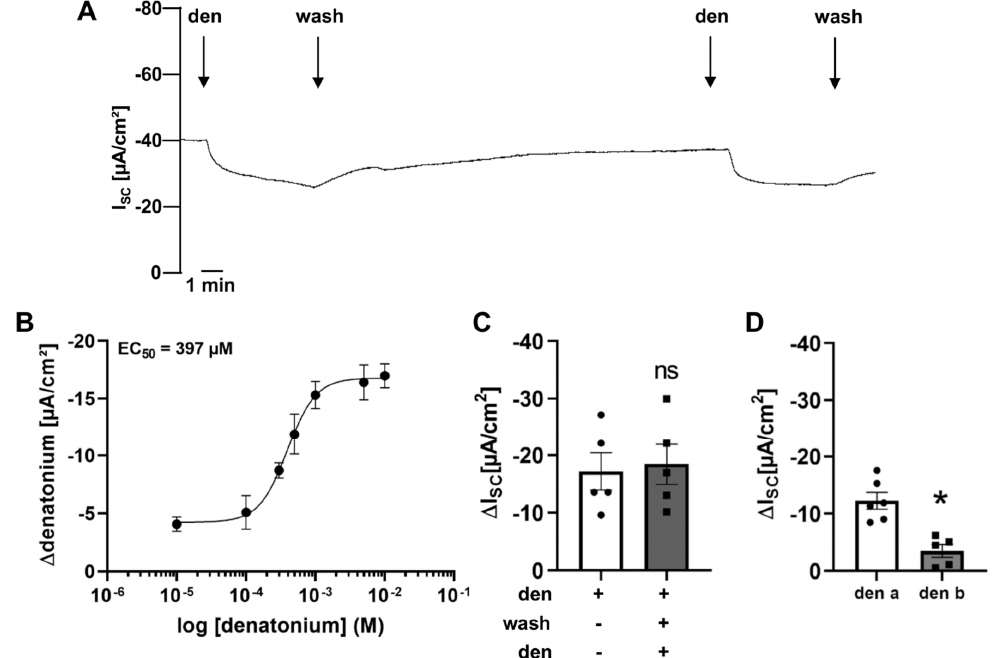
Figure 1. Effect of the bitter taste receptor agonist denatonium on transepithelial ion transport of mouse tracheal epithelium. ( A ) Apical application of denatonium (1 mM) resulted in a decrease in the net short circuit current (I SC ). Representative current trace. ( B ) The denatonium-induced effect was dose-dependent with an EC 50 of 397 µM in wildtype mouse tracheae ( n = 5 for each concentration). ( C ) Repeated application of denatonium (1 mM, apical) on the same trachea showed similar denatonium-modulated current changes ( Δ I SC ) upon the second application ( n = 5, ns: not significant). ( D ) The current changes ( Δ I SC ) upon basolateral application of denatonium (1 mM, n = 5) were smaller than upon apical application (* p < 0.05).